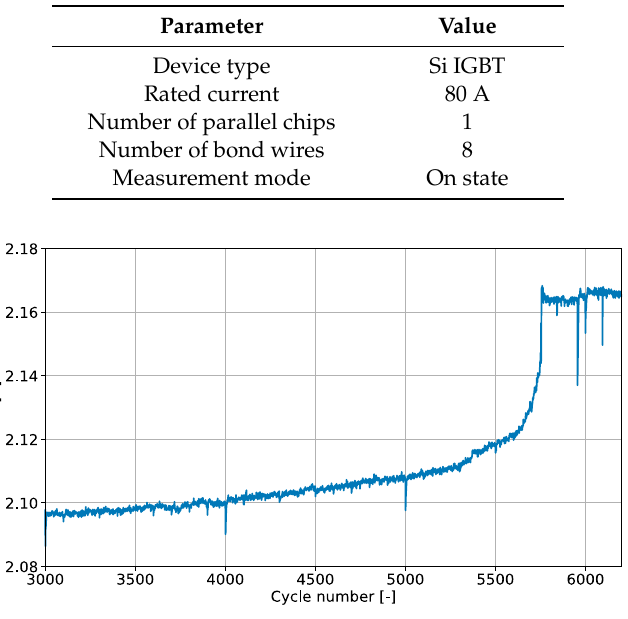
Figure 13. Change of device voltage (VCE) at bond wire break.